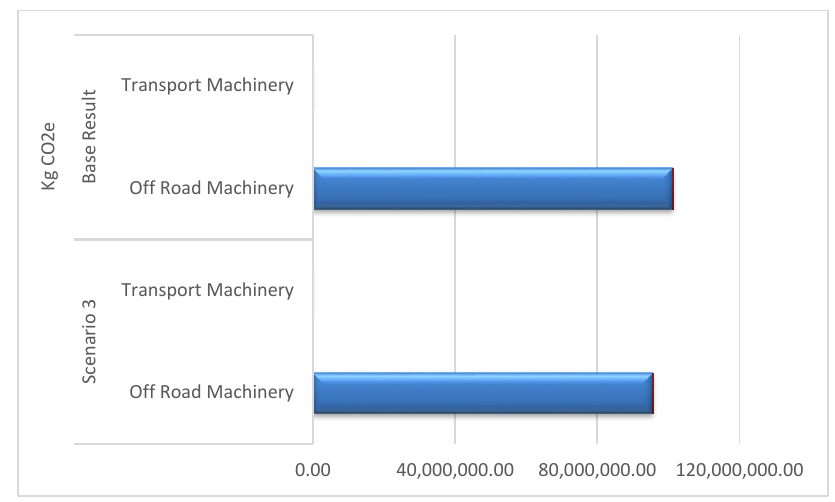
Figure 5. Results of kg CO2e emissions obtained in scenario 3 compared to the base result.